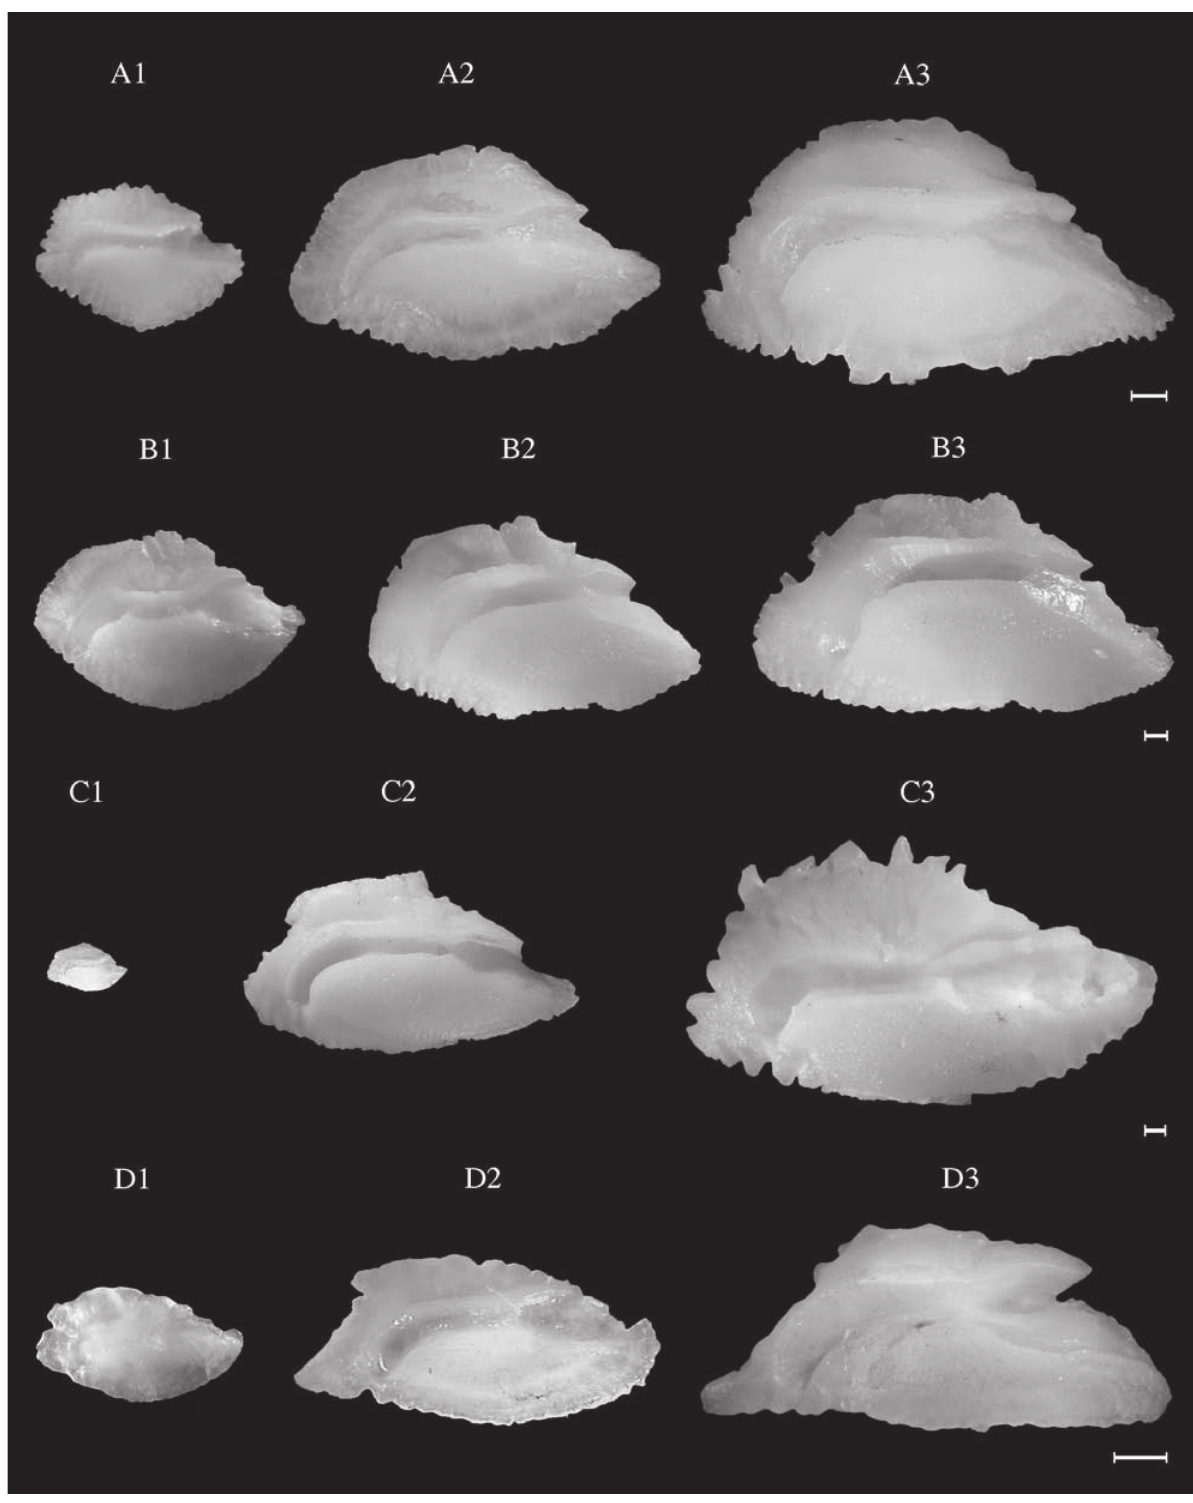
Fig. 61. – Pagrus auriga (CEA) . TL: A1, 17.4 cm; A2, 31.7 cm; A3, 48.3 cm. Pagrus caeruleostictus. TL: B1, 34.2 cm (NEA); B2, 46.6 cm (CEA); B3, 52.2 cm (CEA). Pagrus pagrus . TL: C1, 10.0 cm (WM); C2, 41.0 cm (CEA); C3, 94.0 cm (NEA). Sarpa salpa . TL: D1, 11.4 cm (NEA); D2, 24.5 cm (WM); D3, 43.0 cm (CEA). Scale bar = 1